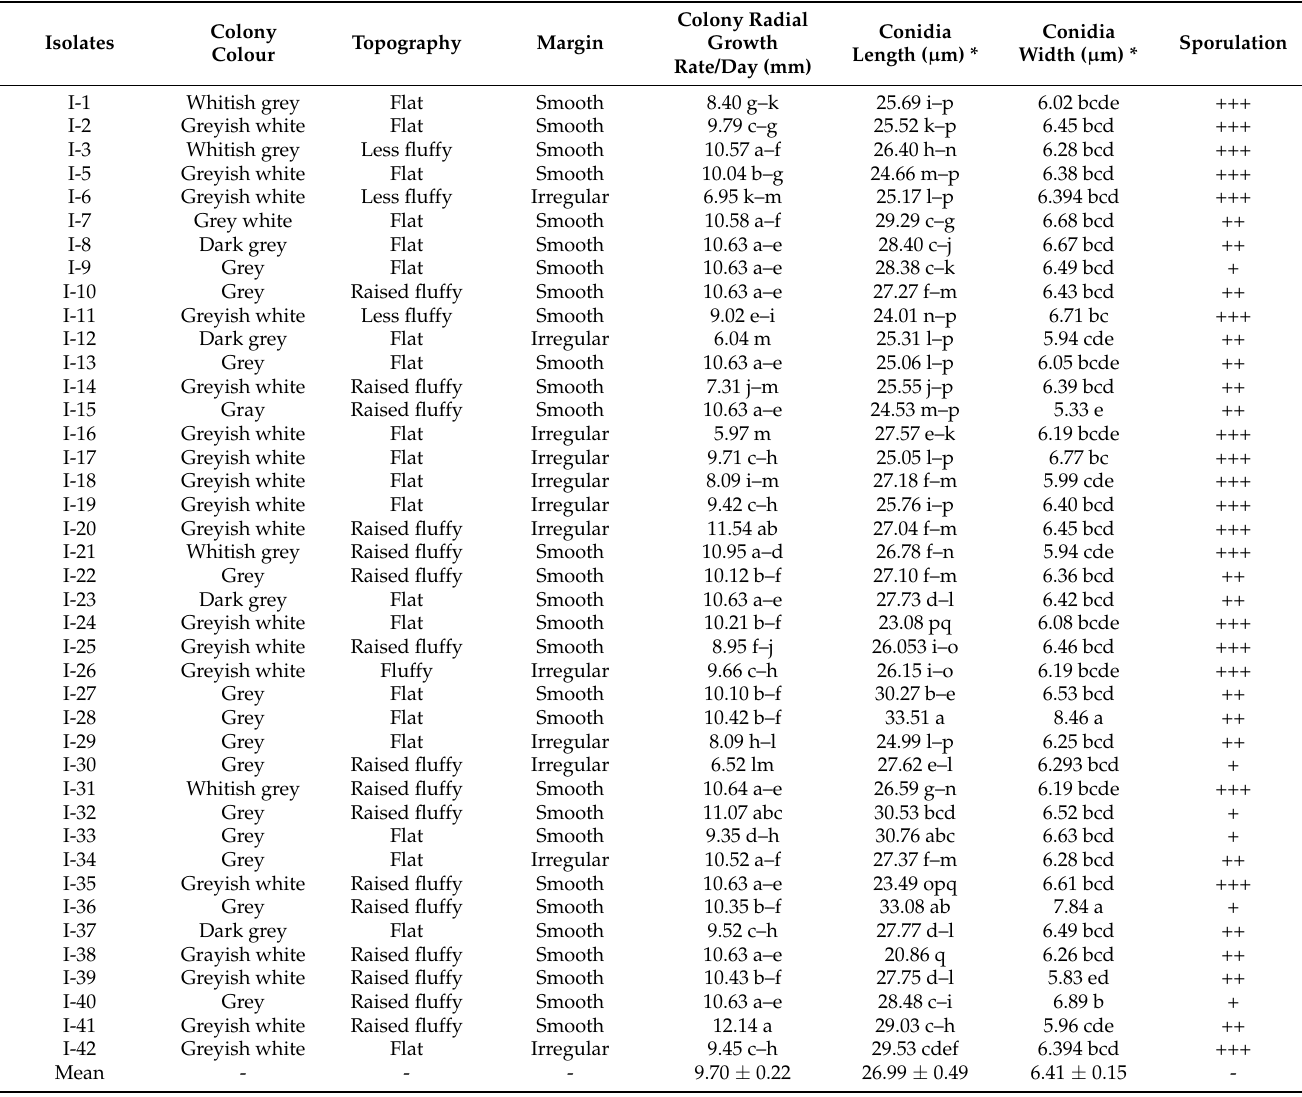
Table 3. Colonies and conidial characteristics of C. falcatum isolates from